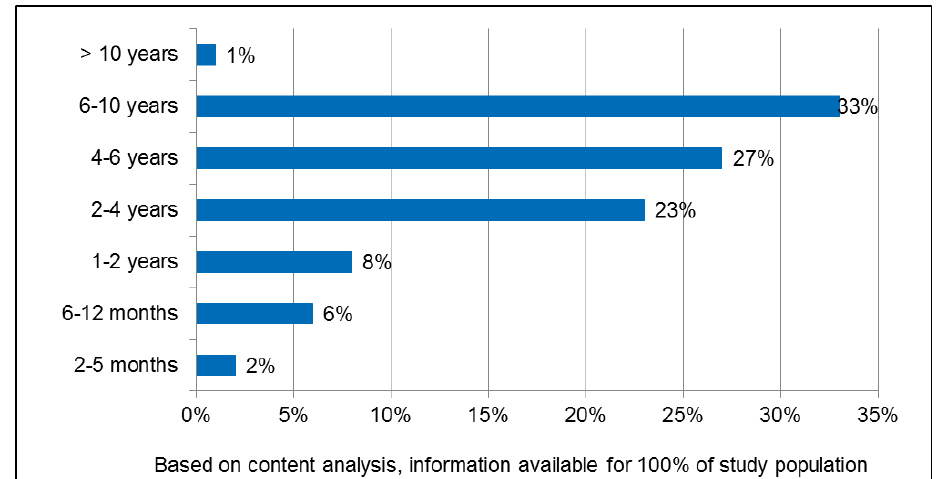
Figure 1: Age of